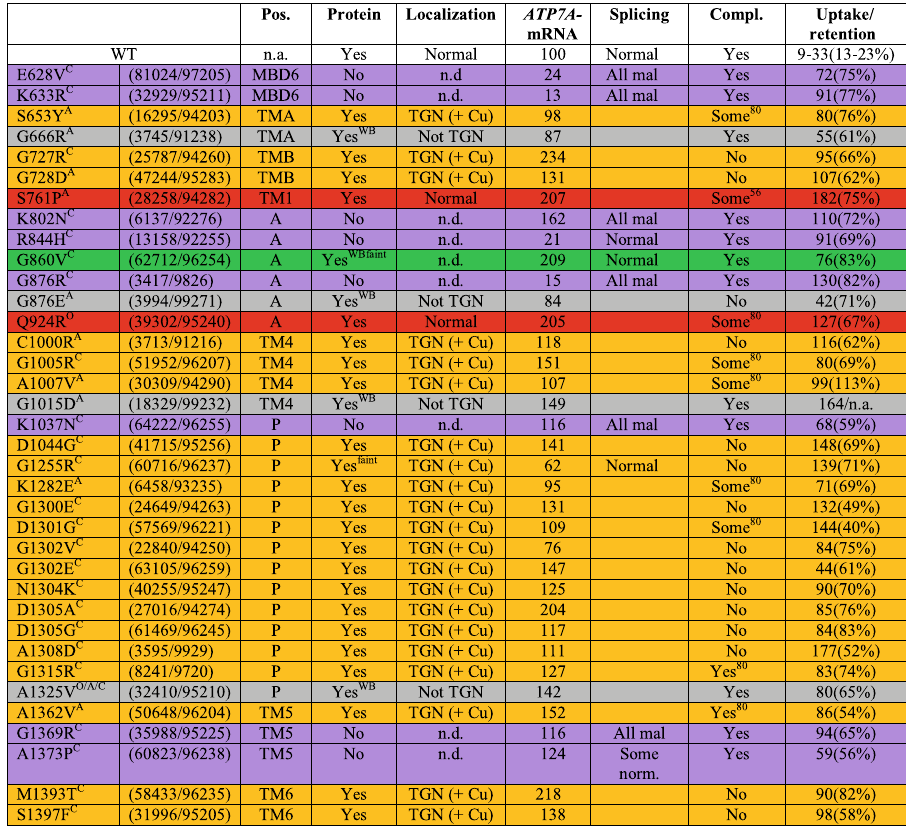
Figure 2. Summary. The color represents the mutational effect on ATP7A localization: Normal trafficking of the protein (blue); retention in post-Golgi compartments (grey); retention in the trans-Golgi network (orange); not certain (green); no detectable protein (purple). “A” denote atypical, “O” OHS, and “C” classical phenotype. Pos: indicates affected region (MBD, TM, A, P). Protein: Indicates whether protein was detectable with IF “Yes” or WB only “Yes WB ”. Localization: Location of ATP7A always in TGN even in the presence of Cu is designated by “TGN( + Cu)”. Never located in TGN is designated by “not TGN”; Location in the TGN only the absence of copper is designated by “normal”. No detectable protein “n.d”. ATP7A-mRNA: indicates % transcript level compared to transcript level in control fibroblasts. Splicing: indicates normal splicing “Normal” or aberrant splicing “All mal”. Empty boxes, indicate “not investigated”. Compl: indicates ability to complement the ccc2 Δ yeast strain. “Some 56 ” and “Some 80 ”, indicate some complementation after 56 hours and 80 hours, respectively. “Yes 80 ” indicates full complementation after 80 hours. If no hours are indicated, it means > 56 hours. Uptake/ retention: Uptake indicates the amount of radioactive copper accumulated after 20 hours incubation ( 64 Cu/mg protein/20 hours). Retention indicated the amount in % of total accumulated 64 Cu retained after subsequent 24 hours in the absence of radioactive